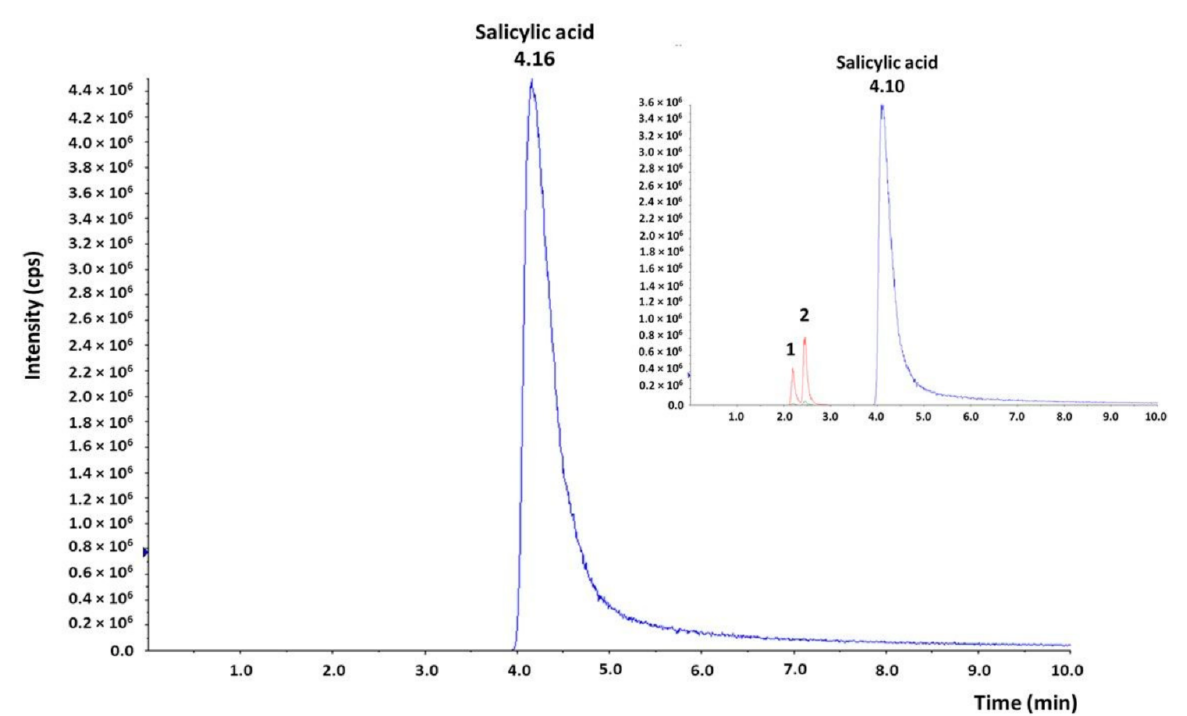
Figure 3. HPLC-MS/MS chromatograms of eye drops with CS (2%) and HA (0.4%) in immediate packaging (minims) after 3 months of storage at 40 ◦ C/75% RH. The inset shows the HPLC-MS/MS chromatogram of eye drops in minims after exposure to light (250 W/m 2 ; 1.2 × 10 6 lux · h): 1—2,5-dihydroxybenzoic acid; 2—2,3-dihydroxybenzoic